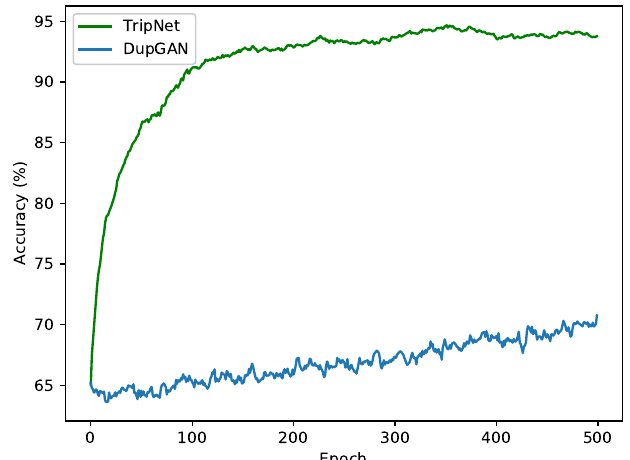
Figure 4. Comparison between TripNet and DupGAN, in terms of the number of iterations needed for convergence in the SVHN → MNIST case. This shows that the generative model comes with a high cost, in terms of training time.